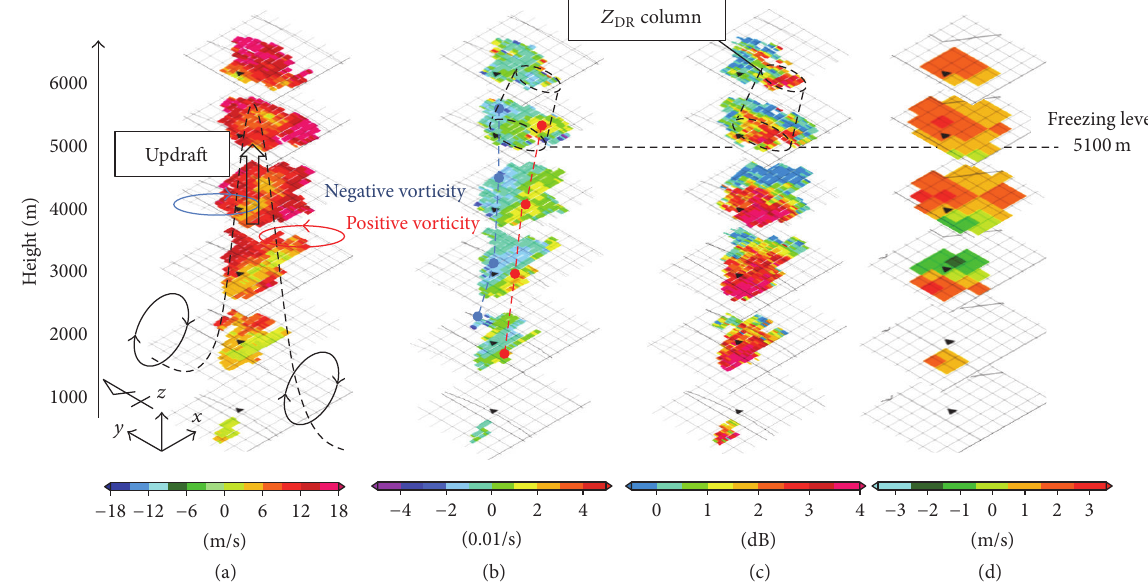
Figure 15: The feature of the event 15 observed by Tanokuchi radar; (a) Doppler velocity and schematic diagram of tilting vortex tube, (b) vorticity calculated using Doppler velocity data, (c) 𝑍 DR , and (d) vertical velocity computed with dual Doppler analysis using Katsuragi and Tanokuchi radar data. The columns described in black color show the region of the high 𝑍 DR column (b,